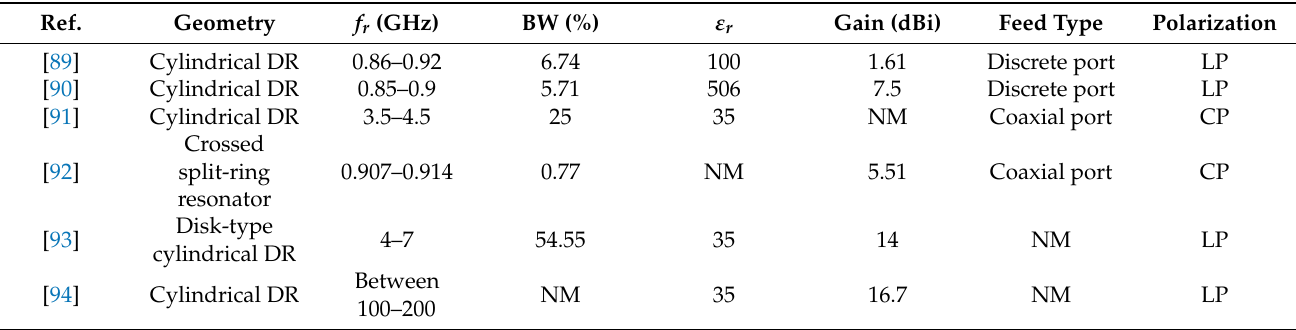
Table 8. Comparison between various DRAs for